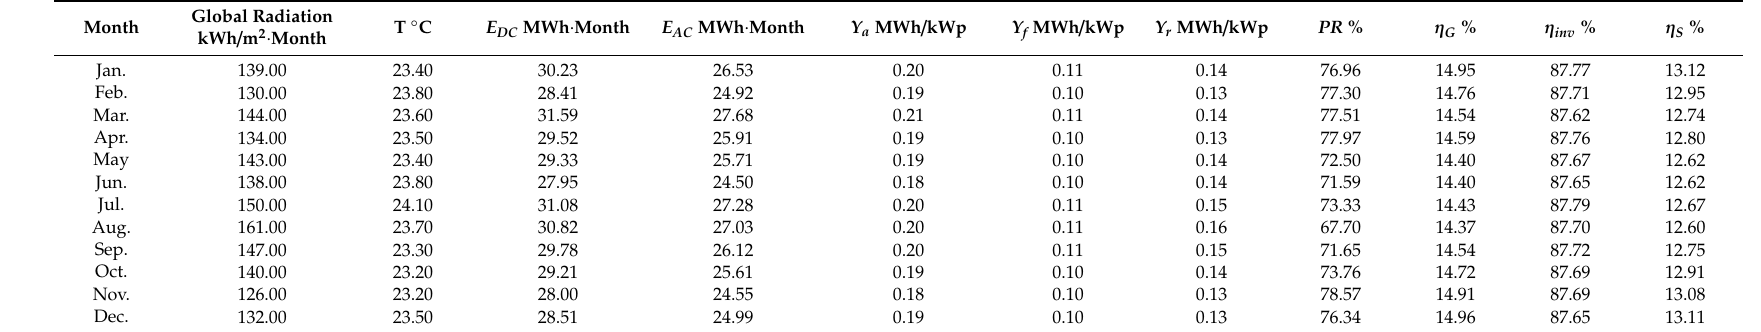
Table 6. Energy e ffi ciency analysis for Stage 2 of the PV system (248